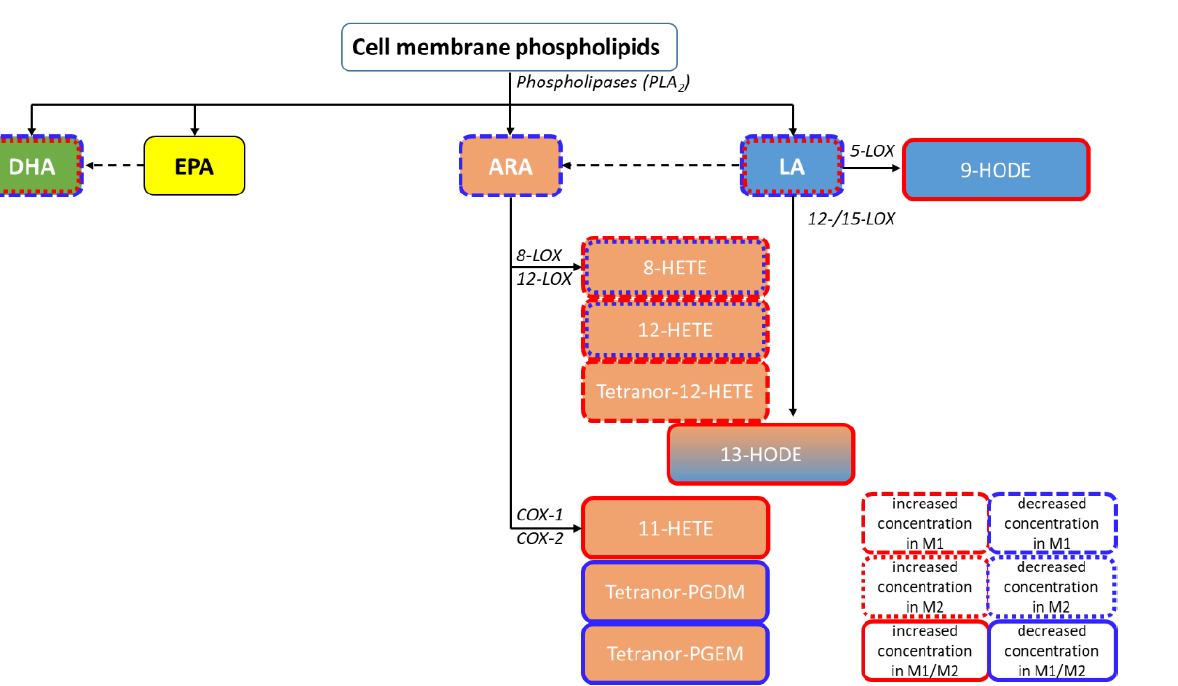
Figure 8. Pathway classification of the quantified PUFA metabolites within the performed independent EV isolations, including the most relevant enzyme classes. Increased concentrations compared to M0 are framed in red and decreased concentrations in blue. ARA—arachidonic acid; COX—cyclooxygenase; DHA—docosahexaenoic acid; EPA—eicosapentaenoic acid; HETE— hydroxyeicosatetraenoic acid; HODE—hydroxyoctadecadienoic acid; LA—linoleic acid;